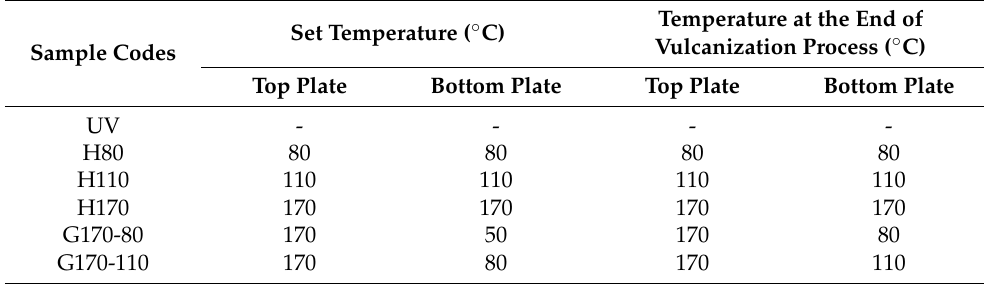
Table 2. Sample codes and temperature conditions at compression